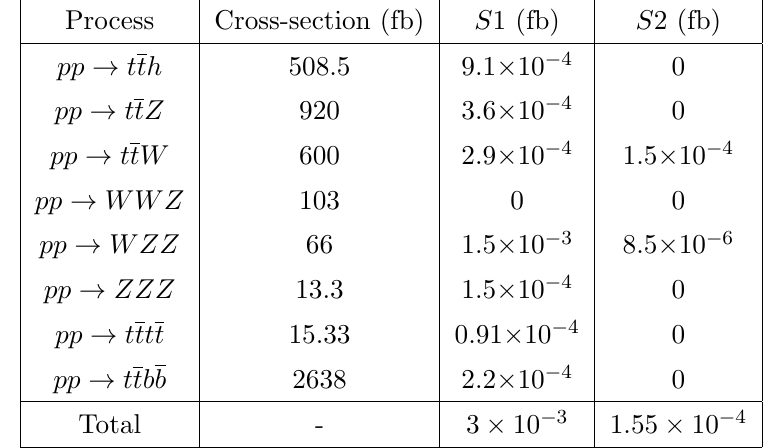
qq(cid:31) Q ) = 0.67. !